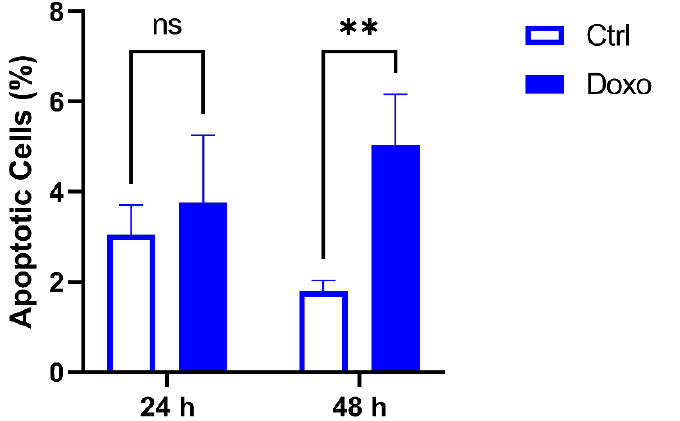
Figure 4. Apoptosis analysis using flow cytometry after staining with Annexin V-BV450. Histograms show the percentage of apoptotic MDA-MB-231 cells after the treatment with doxorubicin at 2.5 µ M for 24 h or 48 h. Data are presented as the means ± SD of triplicate experiments. ** p < 0.01 vs. control (ns, not significant).